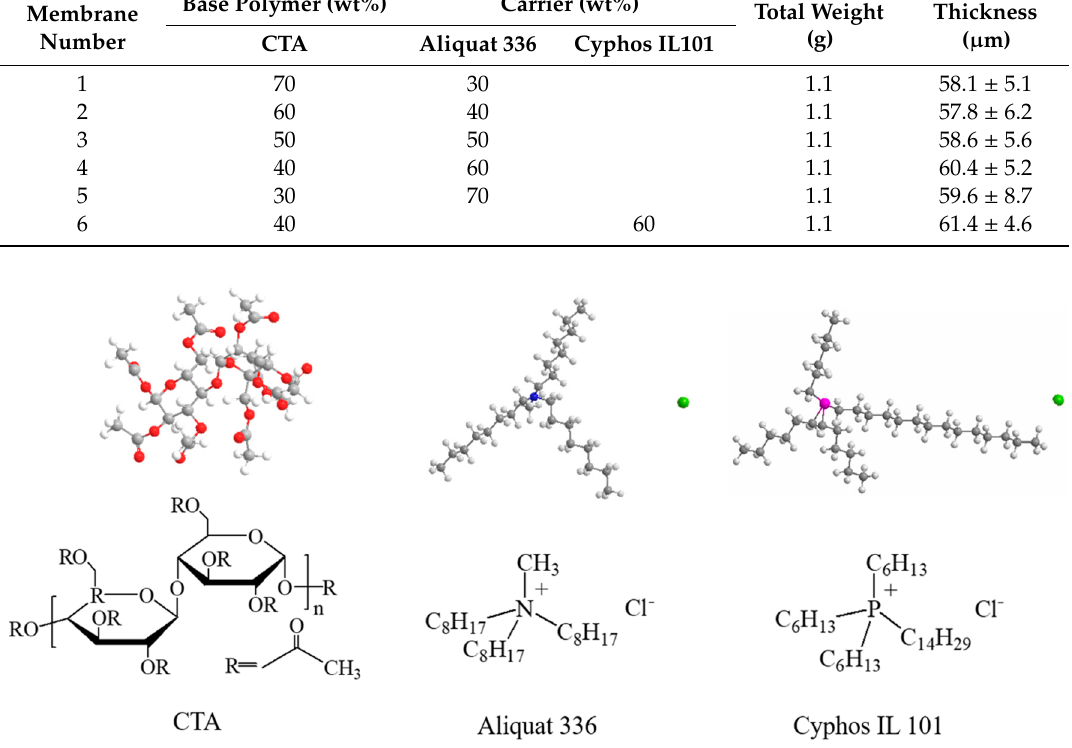
Figure 14. The chemical structures of the polymer and ionic liquids.